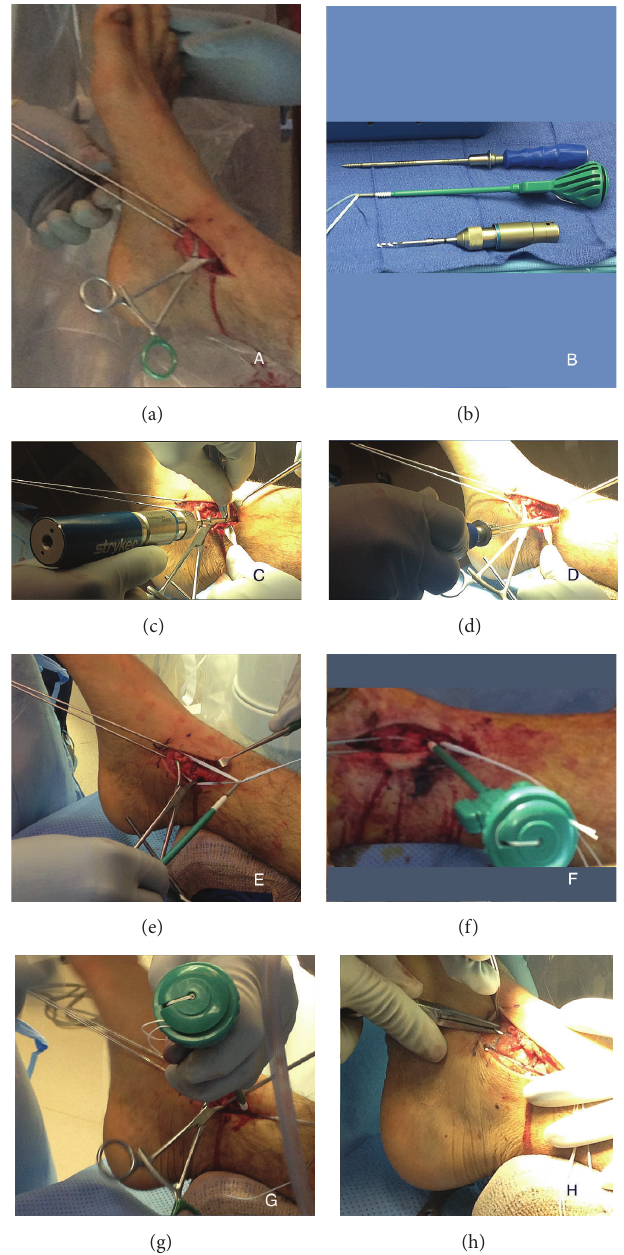
Figure 1: (a) demonstrates reduction of the fracture with two parallel 0.062 k-wires for the tension band effect; (b) shows the 3.4 mm drill, the Arthrex SwiveLock (cid:2) tap, the Arthrex no. 2 FiberTape (cid:2) , and Arthrex 4.75 mm SwiveLock anchor; (c) shows that the 3.4 mm drill was utilized for the anchor hole, being careful to maintain equidistance from the fracture site to the distal portion of the medial malleolus for the anchor hole; (d) shows that the 4.75 mm SwiveLock tap was utilized down to the laser line; (e) demonstrates the FiberTape being wrapped around the distal k-wires and both ends being placed through the 4.75 mm SwiveLock eyelet; (f) shows the FiberTape being tightened to appropriate tension and the SwiveLock anchor was advanced burying the anchor past the black line with the Arthrex AO handle; (g) shows the mallet being used to advance the anchor; (h) shows that the fracture reduced and in adequate anatomical alignment the k-wires were bent, cut, and rotated to avoid soft tissue